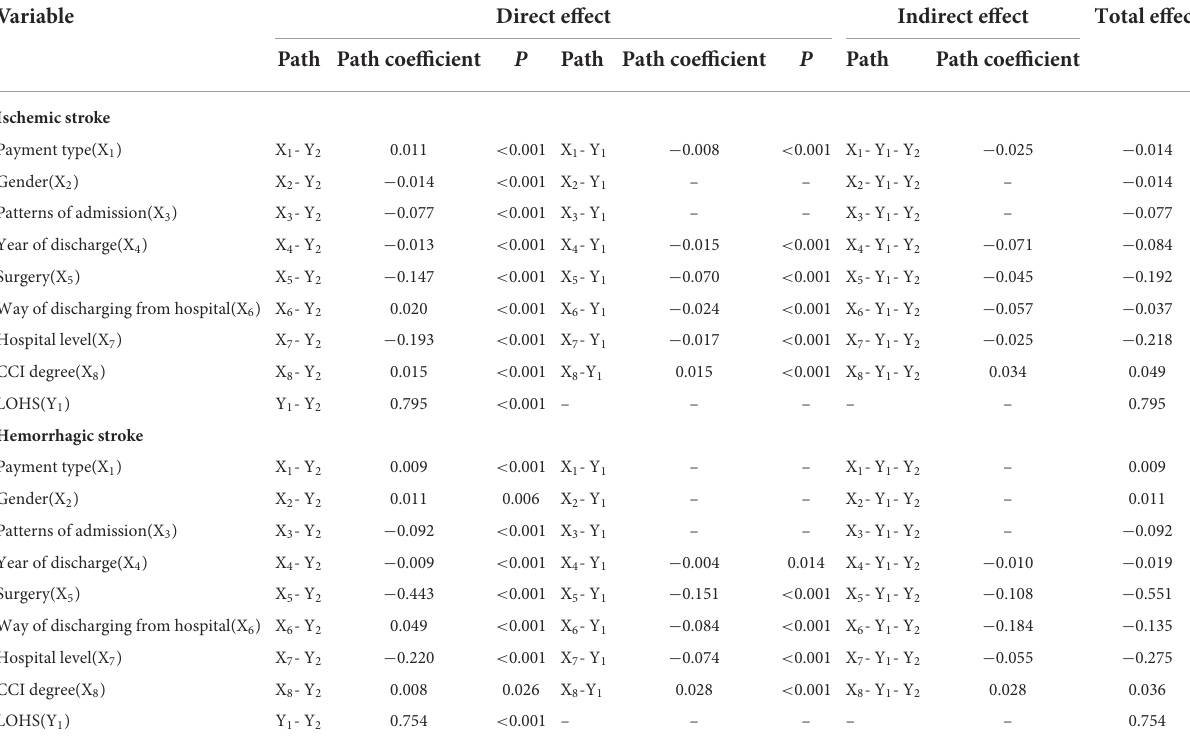
TABLE 4 Effect decomposition of factors influencing hospitalization costs in patients with ischemic and Hemorrhagic stroke.